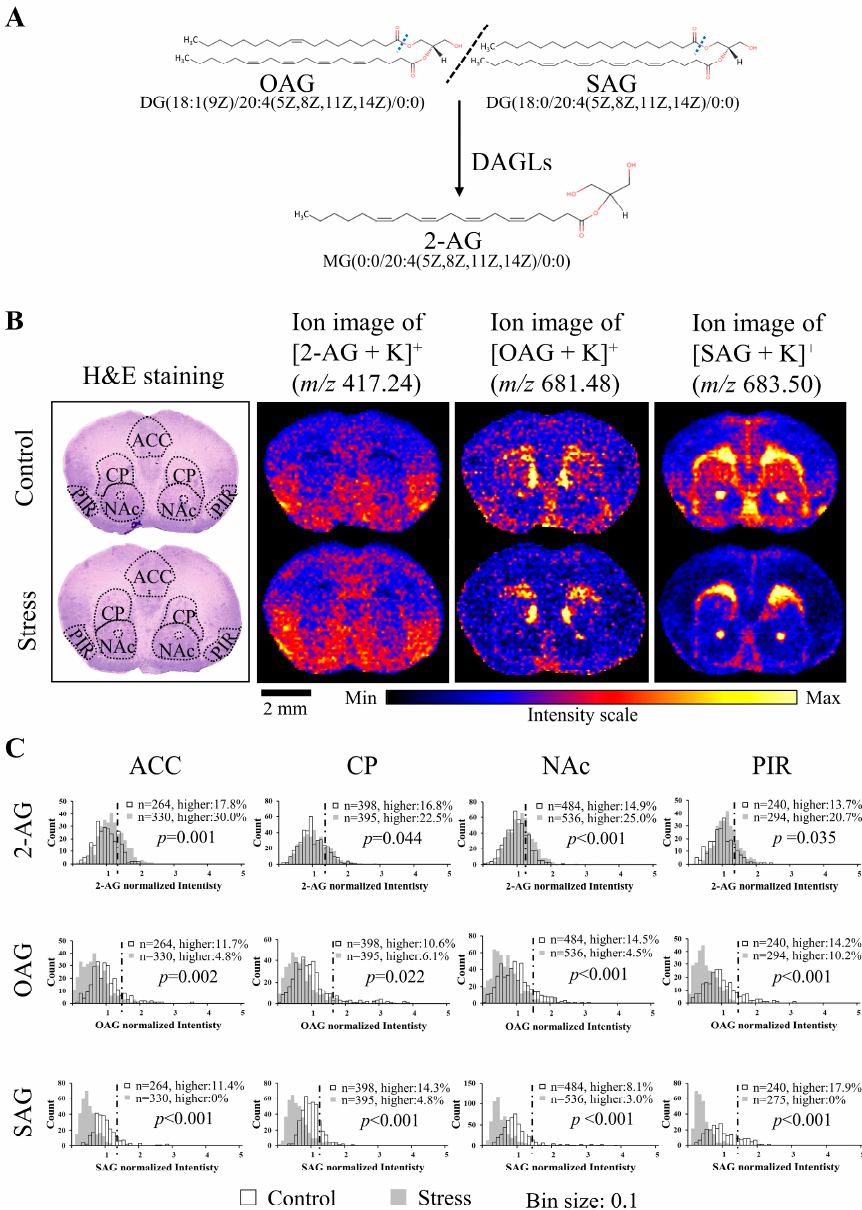
Figure 3. 2-AG levels were upregulated and the levels of OAG and SAG were downregulated in the ACC, CP, NAc, and PIR by CRS. ( A ) Relationship between 2-AG and OAG, SAG. The common name and structure of 2-AG, OAG, and SAG are cited from the Human Metabolome Database (https://hmdb.ca/, accessed on 1 November 2022). ( B ) H&E staining results and ion images of 2-AG, OAG, and SAG in coronal brain sections of control and stressed mice (scale bar: 2 mm). ACC, CP, NAC, and PIR in control and stressed mice brains were circled by a black dotted line for analysis. Anatomical annotations followed Allen Brain Atlas. ( C ) Histograms represent the intensity change of 2-AG, OAG, and SAG in the ACC, CP, NAC, and PIR of control and stressed mice. The value of each pixel in the stress and control groups was normalized by dividing the mean of the control group. The horizontal axis of the histograms represents the normalized signal intensity level, and the vertical axis indicates the frequency of pixels. A threshold line was set as mean + SD of the control mice. Pearson’s Chi-square test was performed for lower-than-threshold and higher-than-threshold signals in these two groups (n: the number of pixels). OAG: 1-oleoyl-2-arachidonoyl-sn-glycerol, SAG: 1-stearoyl-2-arachidonoylglycerol, DAGL: diacylglycerol lipases, ACC: anterior cingulate cortex, CP: caudate putamen, NAc: nucleus accumbens, PIR: piriform